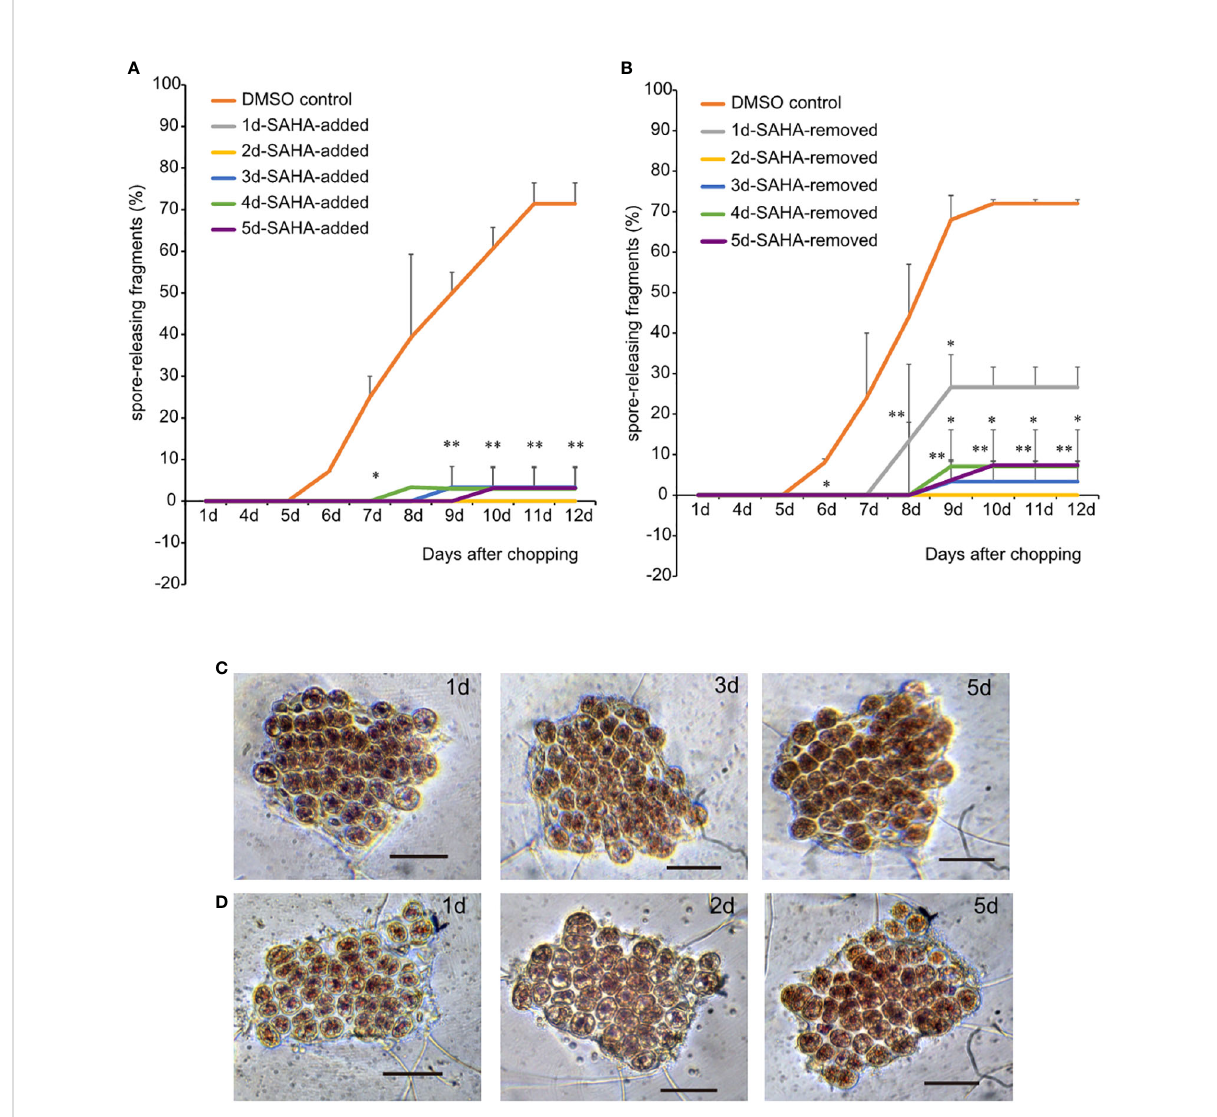
FIGURE 3 Effects of transient SAHA treatment on wound-induced spore formation. (A) Effect of SAHA post-treatment on the percentage of spore formation. The sample with SAHA added to media on day 1 after wounding was marked as 1d-SAHA-added and so as the other samples. Error bars represent the SD (n = 3, 30 fragments/replicate as described in “ Materials and Methods ” section).*, 0.01 < P-value <0.05; **, P-value < 0.01. (B) Effect of SAHA pre-treatment on the percentage of spore formation. The sample with SAHA removed on day 1 after wounding was marked as 1d-SAHA-removed and so as the other samples. (C, D) , The morphological changes of 1d-SAHA-added (C) and 2d-SAHA-added (D) thallus fragments (Bar = 50 m